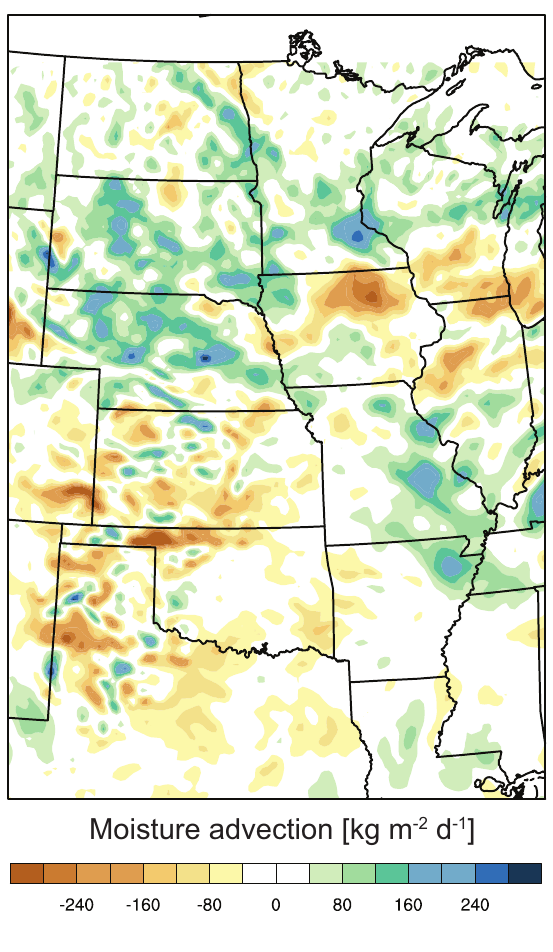
Figure 11. Difference in monthly-mean vertically-integrated horizontal moisture advection (IRR–CTL) for the month of